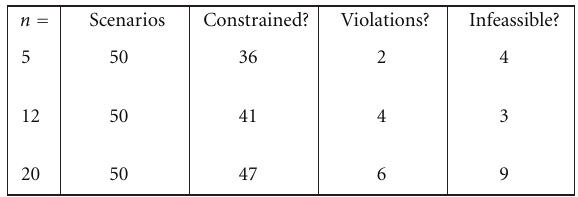
Figure 7: Simulation results for connectivity algorithm.